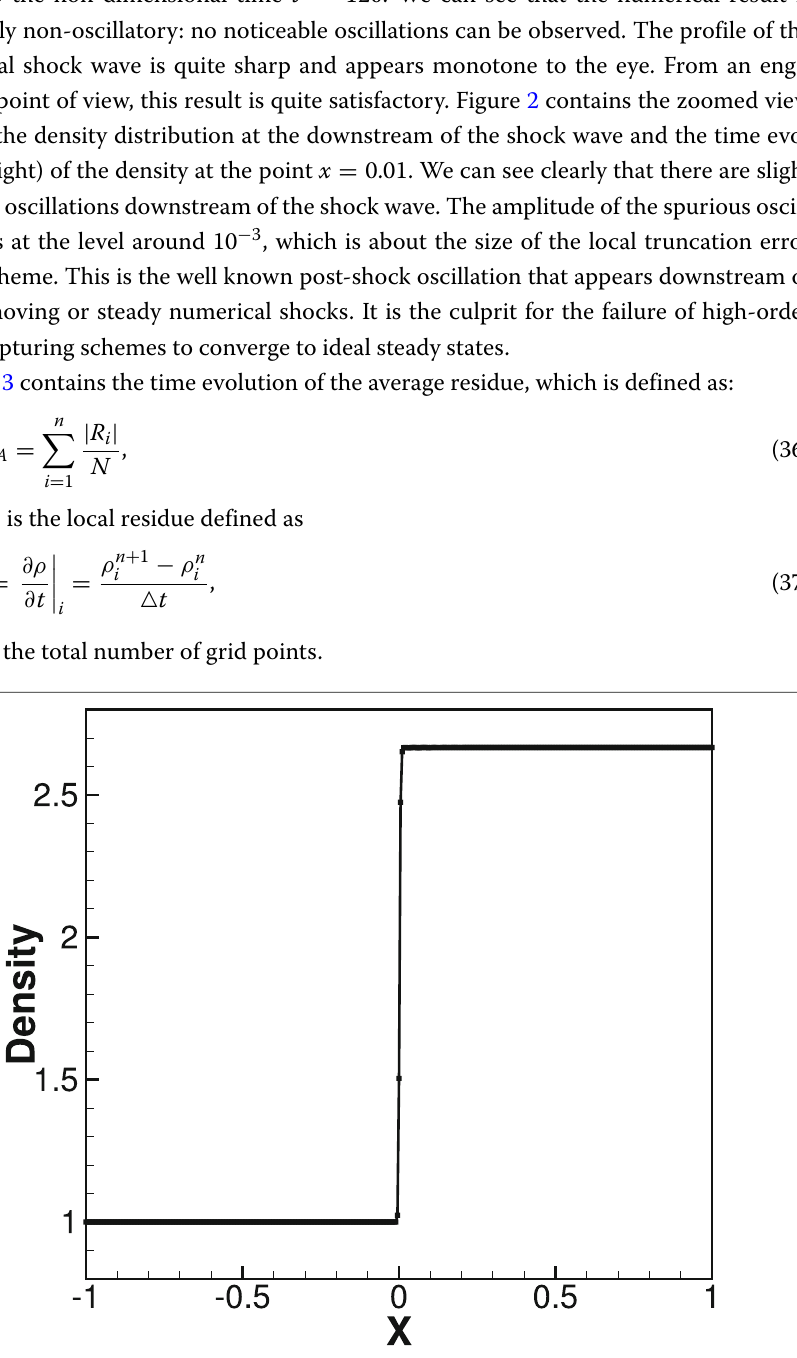
Fig. 1 Density distribution along the computational domain of 1D steady shock wave with Mach number M ∞ =